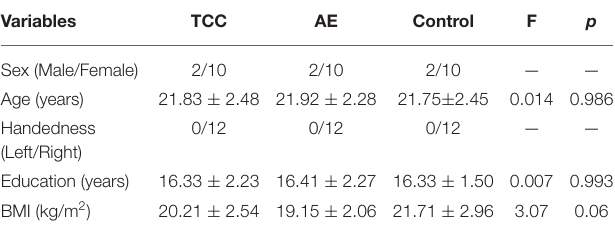
TABLE 1 | Sample characteristics (M ±